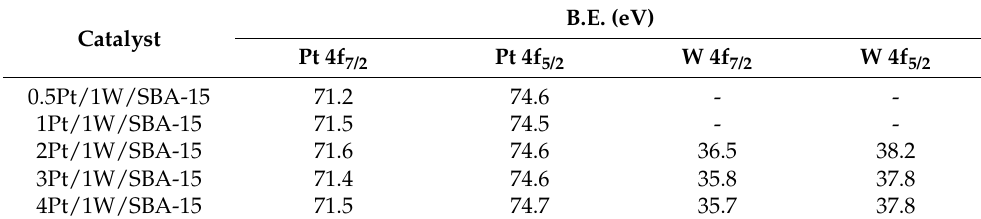
Figure 4. X-ray photoelectron spectra of 4Pt/1W/SBA-15 from Pt 4f ( left ) and W 4f ( right ) core level regions; experimental spectrum—black continuous line, simulated spectrum—red continuous line, baseline correction—green dashed line and deconvoluted spin-orbit doublet (4f 7/2 and 4f 5/2 ) lines—blue dashed lines. Table 1. X-ray photoelectron spectral data of Pt/W/SBA-15 catalysts.